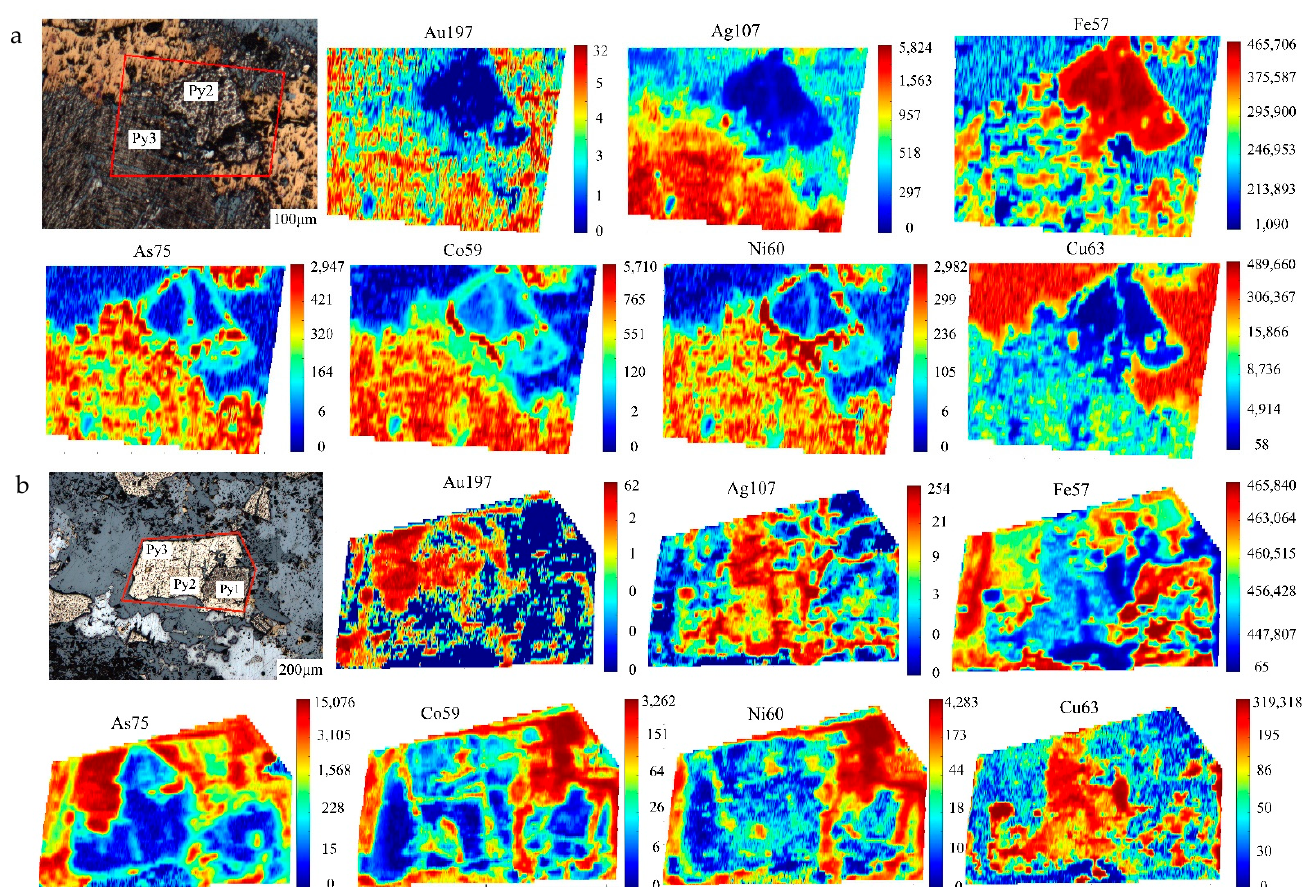
Figure 6. Laser ablation inductively coupled plasma mass spectrometry mapping of trace elements (Au197, Ag107, Fe57, As75, Co59, Ni60, and Cu63) in pyrite of Fang’an deposit: ( a ) showing trace element contents of Py2 and Py3 in sample ZK141-H1; ( b ) showing trace element contents of Py1, Py2, and Py3 in sample ZK1549.